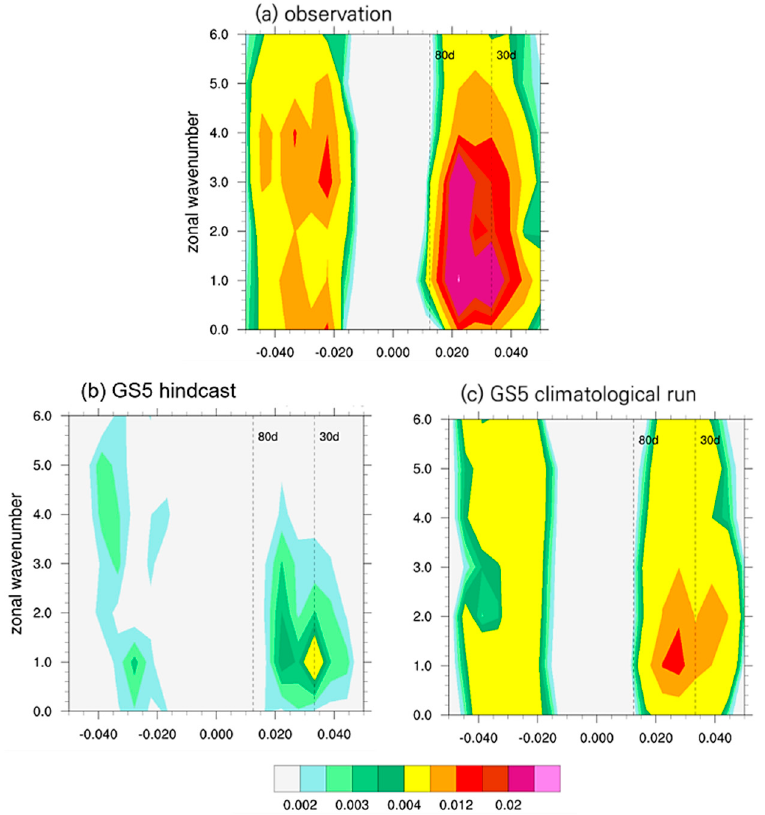
Figure 4. Frequency–wavenumber spectrum of precipitation (mm − 2 day − 2 ) averaged over 10° N–10° S from ( a ) observation, ( b ) the GS5 hindcast, and ( c ) the GS5 climatological run during boreal winter (November–April). Twenty to seventy day filtered data were used for calculation.